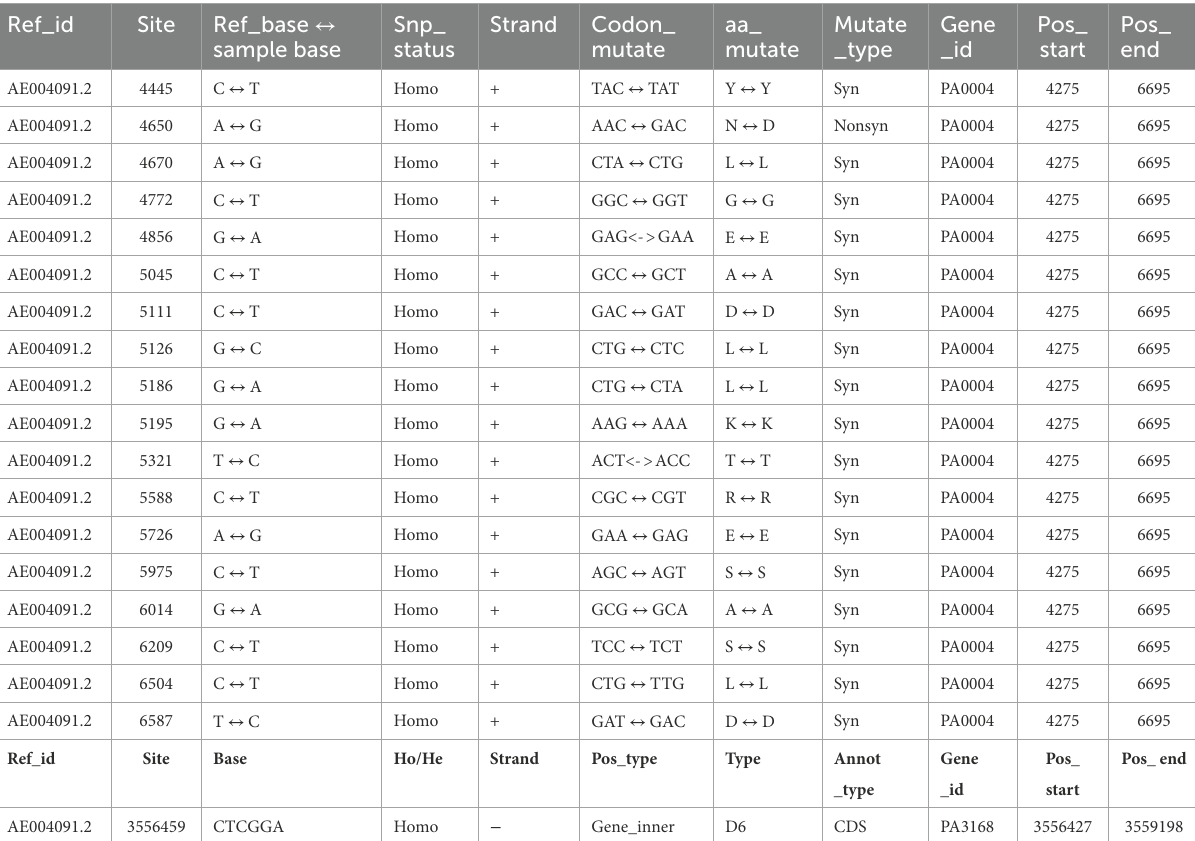
TABLE 2 Single-nucleotide polymorphism (SNP) and insertion–deletion (InDel) gene information of gyrB (PA0004) and gyrA (PA3168) of Pseudomonas aeruginosa PAS81 based on bacterial genome sequencing.